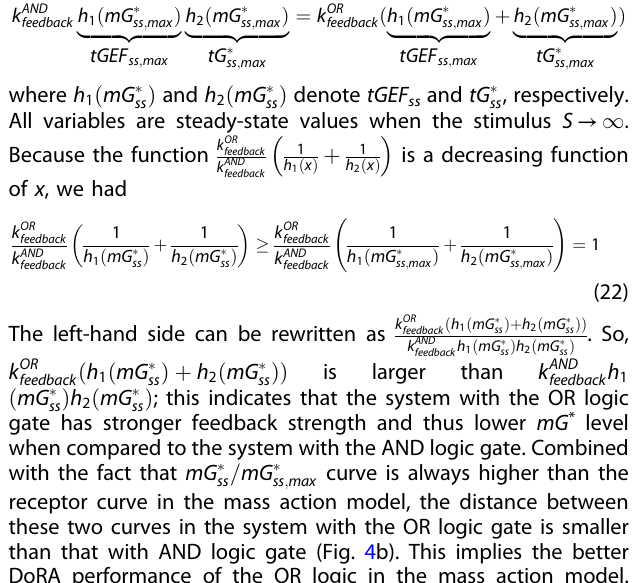
, respectively. ss